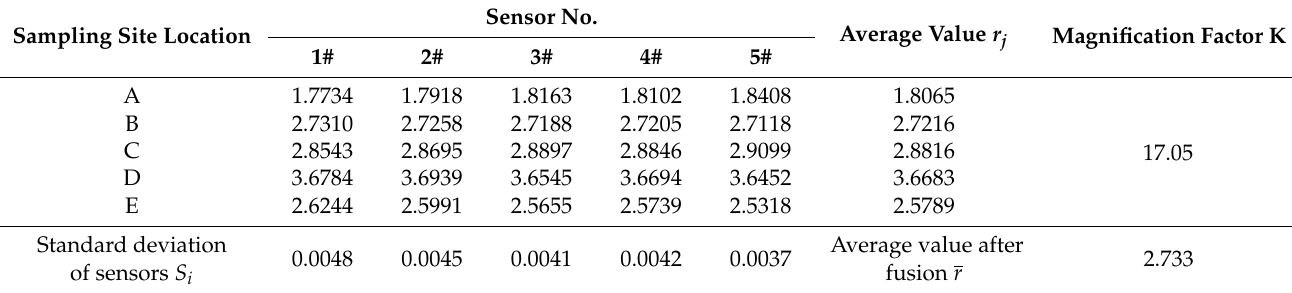
Table 3. List of the fusion values of the detection values of each sensor at different detection points (mm).